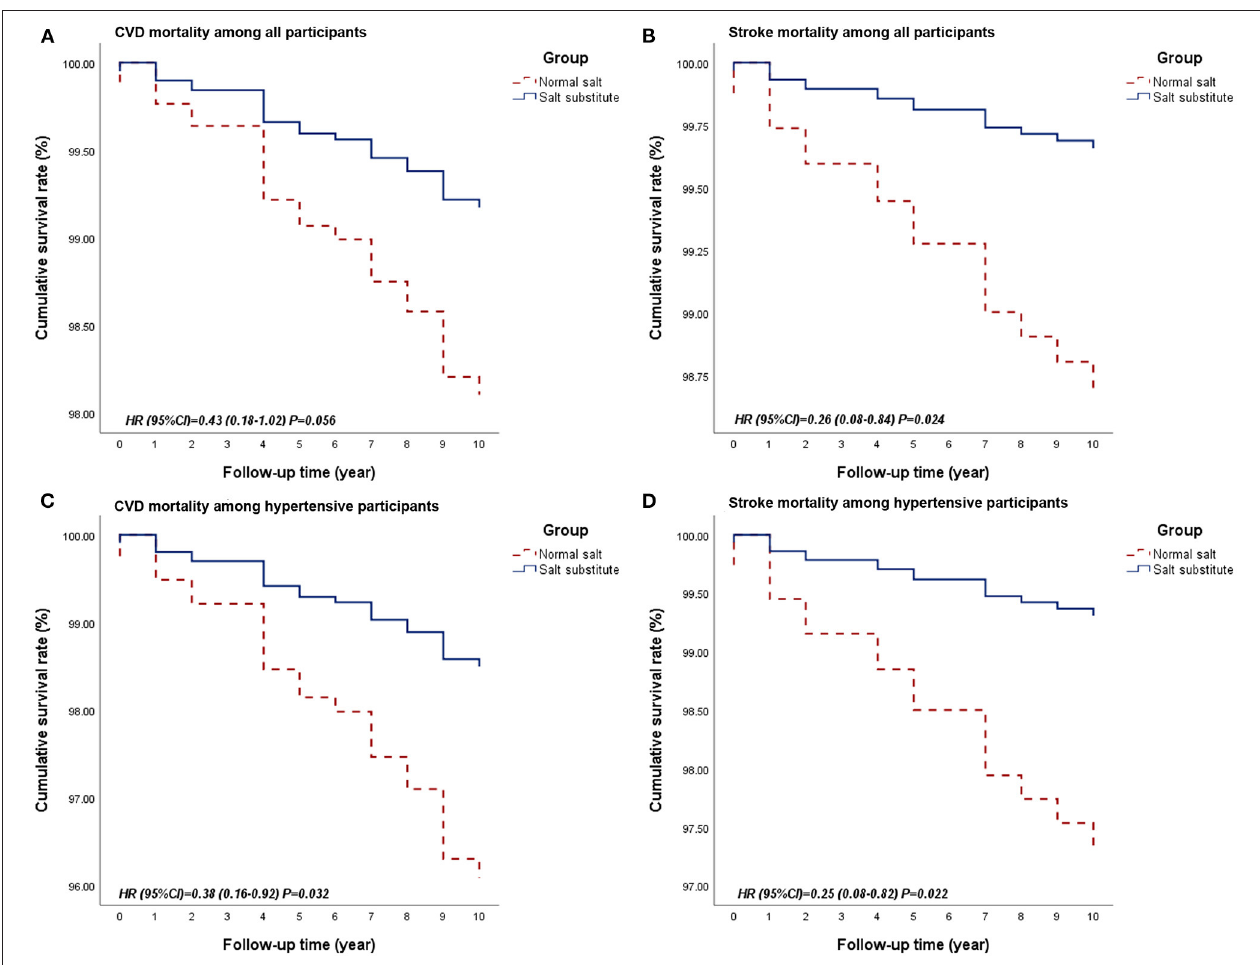
FIGURE 2 | Survival curves of CVD and stroke mortality between groups among all participants or hypertensive participants. ( A. Survival curve for CVD mortality among all participants; B. Survival curve for stroke mortality among all participants; C. Survival curve for CVD mortality among hypertensive participants; D. Survival curve for stroke mortality among hypertensive participants.) CVD, Cardiovascular